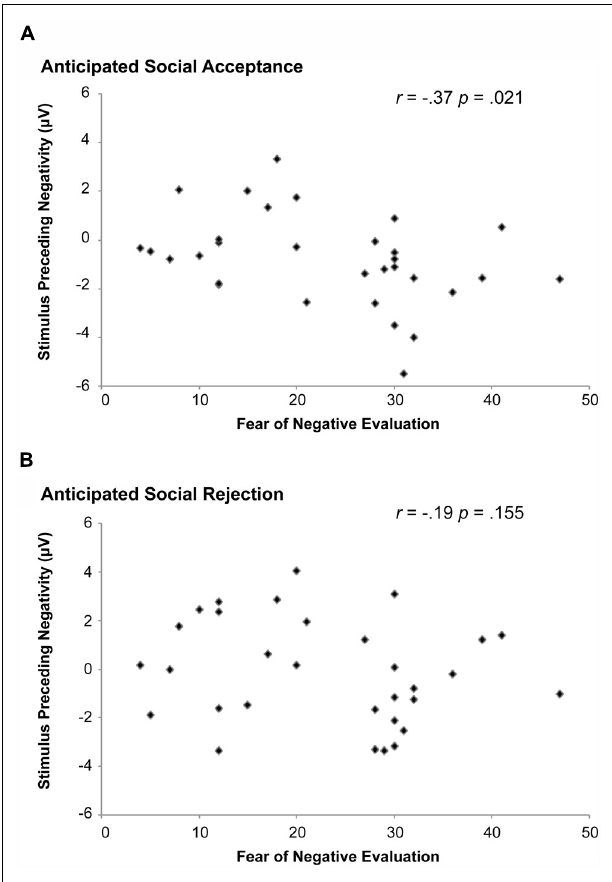
FIGURE 4 | Correlation between SPN amplitude and the fear of negative evaluation (FNE). A significant correlation was observed between the SPN and FNE when participants were anticipating social acceptance (A) .This effect was not observed when participants were anticipating social rejection (B)